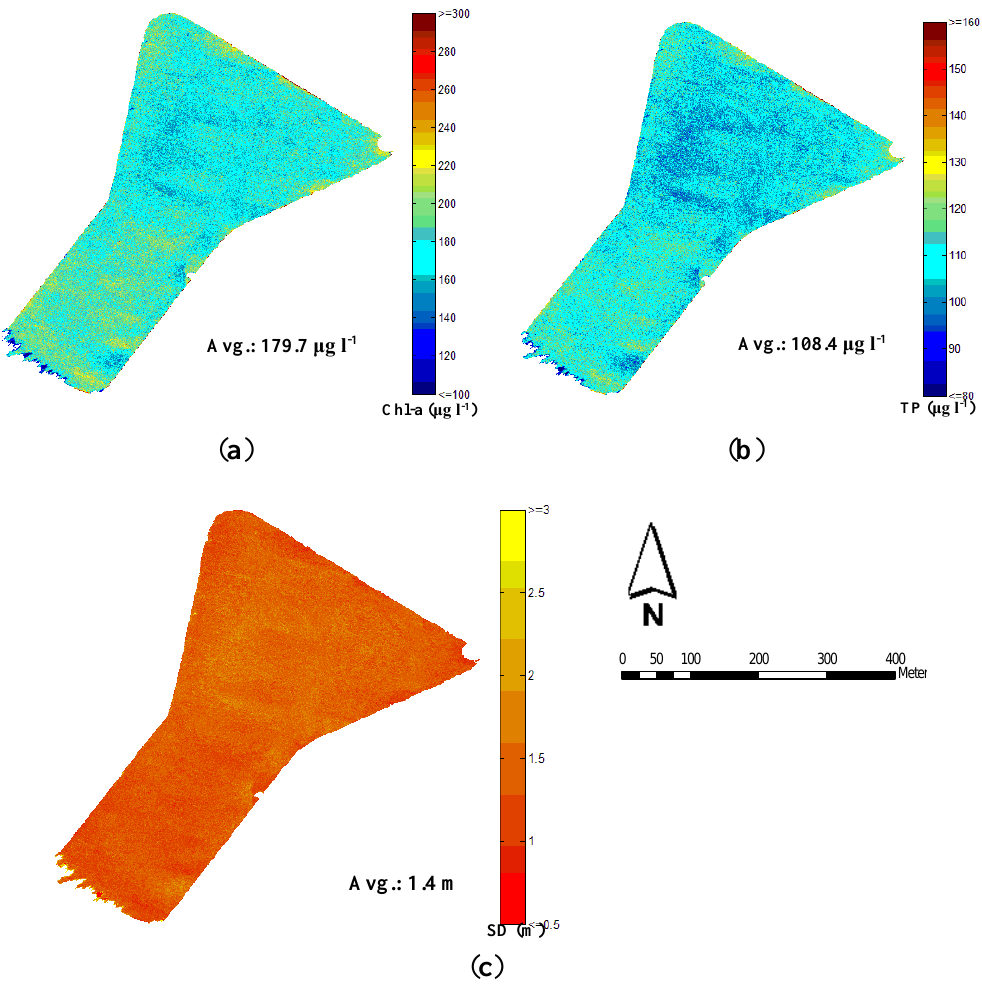
Figure 6. Concentration maps of water quality parameters of Tain-Pu reservoir on 24 November 2014: ( a ) Chl-a concentration map; ( b ) TP concentration map; ( c ) SD depth